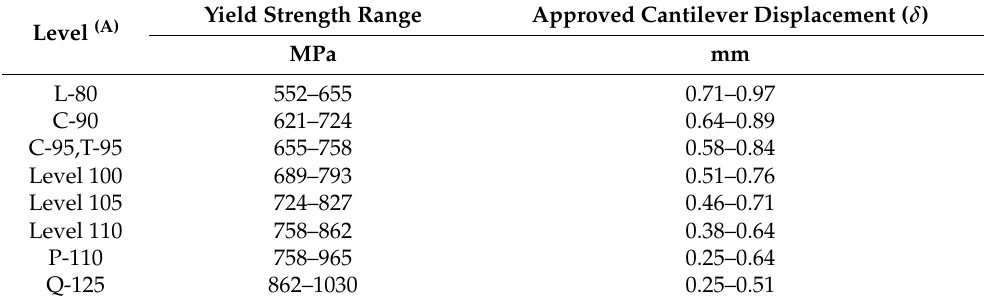
Table 3. Cantilever displacement of oil casing